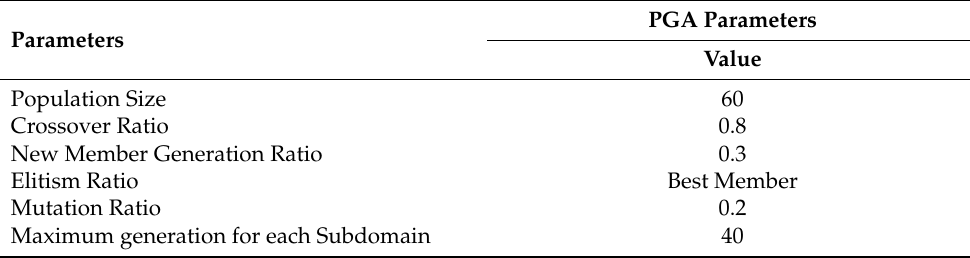
Table 3. Parameters used in PGA application.